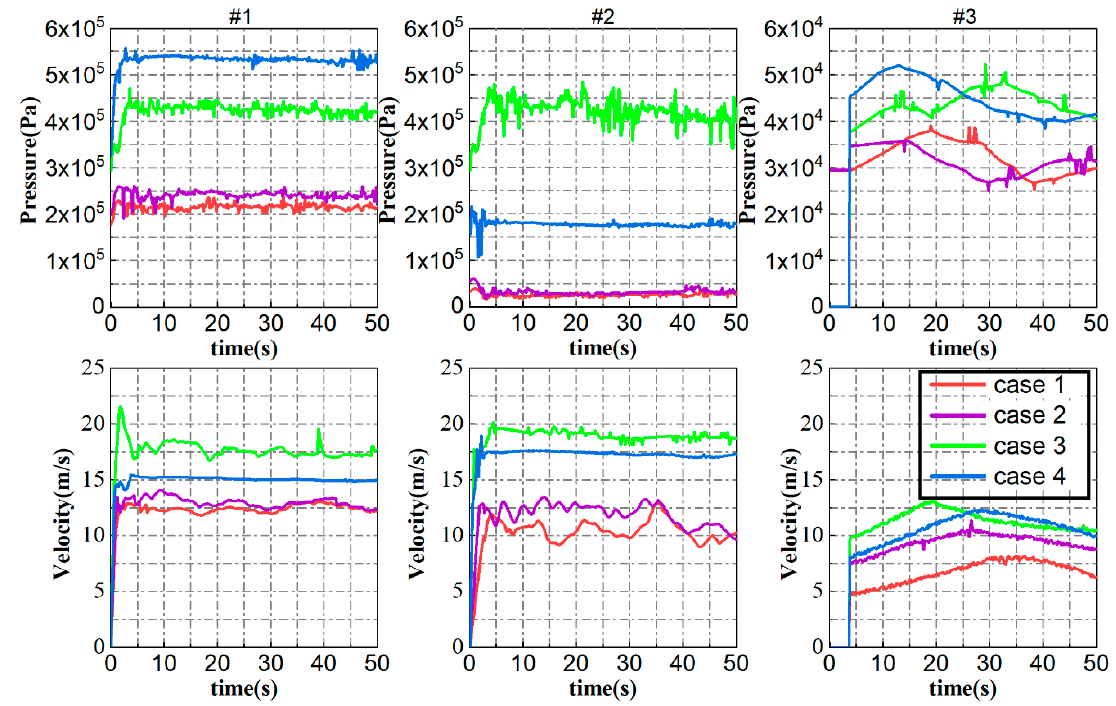
Figure 13. Pressure and velocity profiles at each probe point.